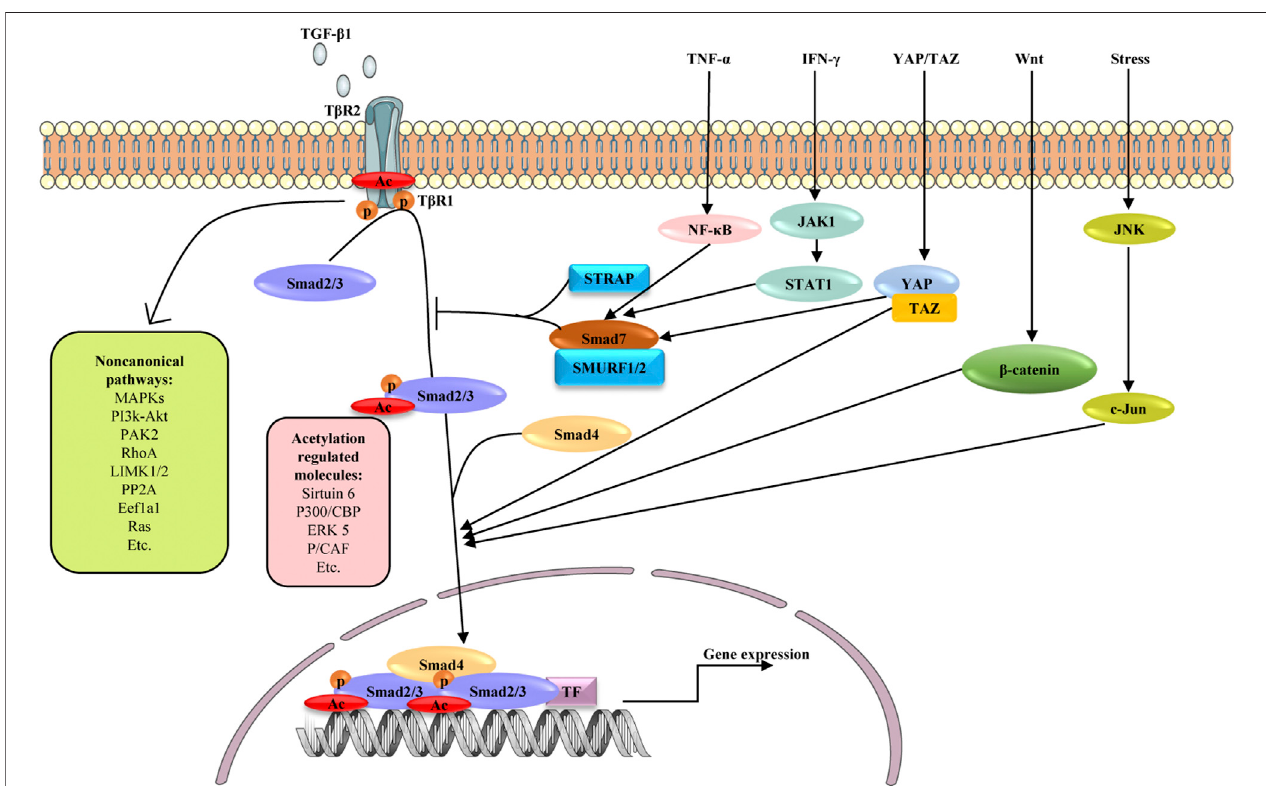
FIGURE 3 | Schematic diagram depicting possible mechanisms involved in the fi brogenesis of TGF- β signaling and its crosstalk with other signaling pathways. Signaling starts with TGF- β binding to TGF β R2 (T β R2), which activates TGF β R1 (T β R1). The active T β R1 phosphorylates and acetylates Smad2/3, which complex with Smad4, translocate into nucleus and promote pro fi brotic genes expression. As another active form of Smad2/3, acetylated Smad2/3 are reported to be regulated by Sirtuin6, P300/CBP, ERK5 and P/CAF. Smad7 negatively regulatesTGF- β signaling through competing with Smad2/3 for interaction with T β R1 in the presence of STRAP and SMURF1/2. TGF- β can also activate non-canonical TGF- β pathways, including MAPK, PI3K/AKT, PAK2, RhoA, LIMK1/2, p P2A, Ee fl a1and Ras pathways. Inadditiontocanonicalandnon-canonicalpathways,TGF- β /Smadsignalingsharescrosstalkwithothersignalingpathwaysinliver fi brosis,includingTNF- α ,IFN- γ ,YAP/ TAZ, Wnt and JNK signaling. These pathways in fl uence TGF- β signaling by affecting the activation and nuclear translocation of Smad2/3. TF: transcription factors, p: phosphate group, Ac: acetylate